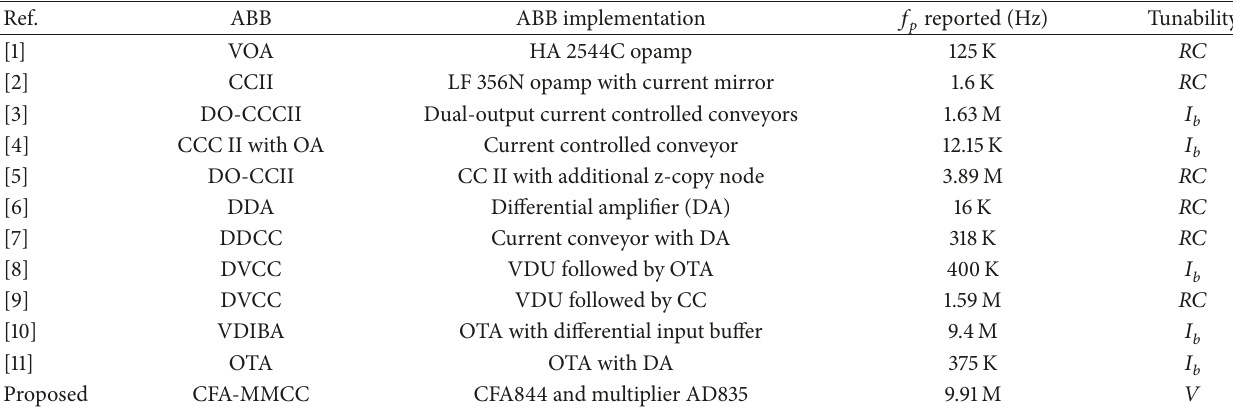
Table 1: Comprehensive summary of recent